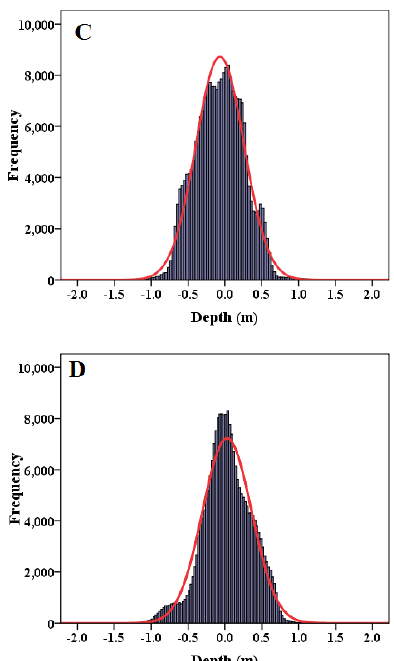
Figure 6. Histogram of depth difference between known depth and bands 2, 3 and 4 in linear relation (C); Histogram of depth difference between real depth and the same bands in exponential relation (D); the red curve in both figures represent normal